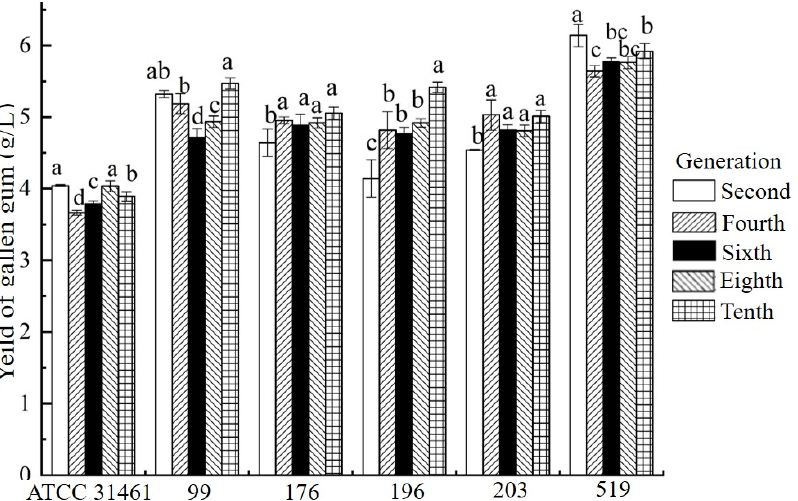
Figure 4. Genetic stability of the high-yield gellan gum mutants within ten generations. Different letters represent a significant difference between the two in a strain ( p < 0.05).